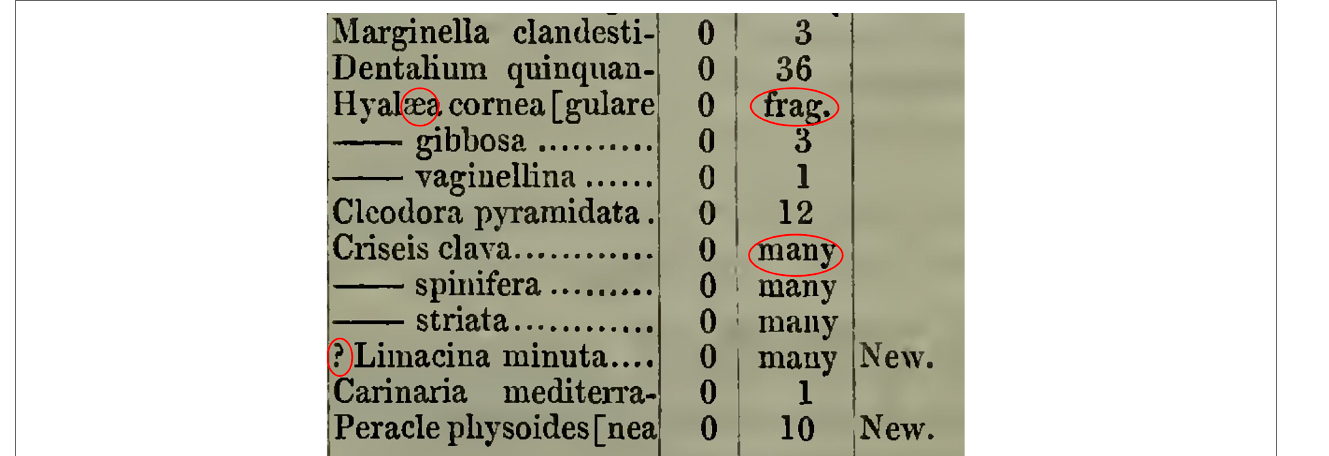
FIGURE 2 | Common problems encountered in historical data, such as old ligatures, absence of taxon names, ambiguous symbols, shortened words and descriptive information instead of numerical (page 185 from Forbes,